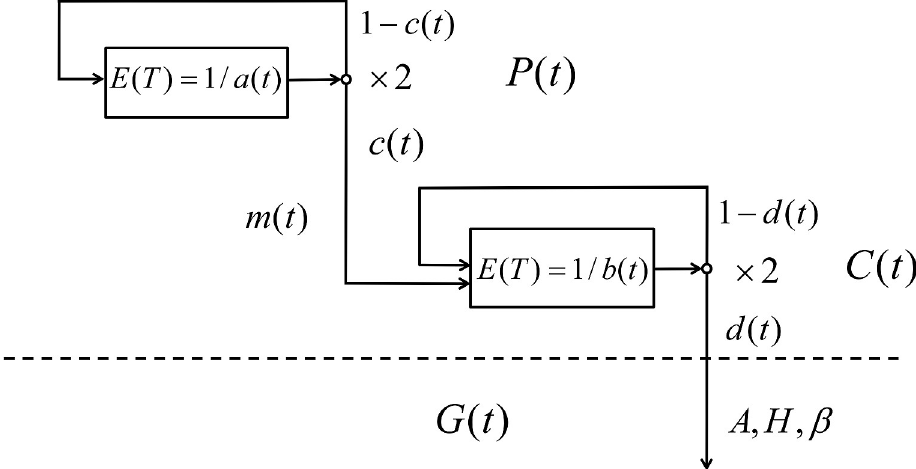
Fig 5. Deterministic model of age-related dynamics of pluripotent and committed cells and granulocytes. P ð t Þ , C ð t Þ , and G ð t Þ are the numbers of pluripotent cells (HSC compartment), committed cells (CMP compartment), and peripheral granulocytes at time t , respectively; m is the ratio of the committed cells in the hematopoietic cell lineage associated with the granulocyte line (assumed to be m ¼ 1 = 4 Þ ; a and c are the proliferation rate and self-renewal probability of the P cells; and, similarly, b and d are the proliferation rate and self-renewal probability of the C cells. E ð T Þ denotes expected interdivision time of a